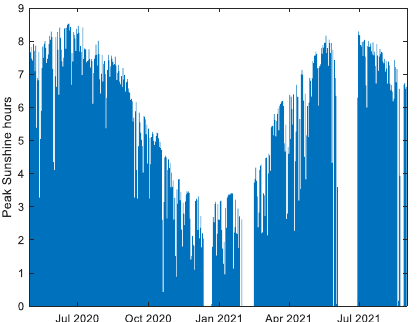
Figure 5. Peak sunshine hours.